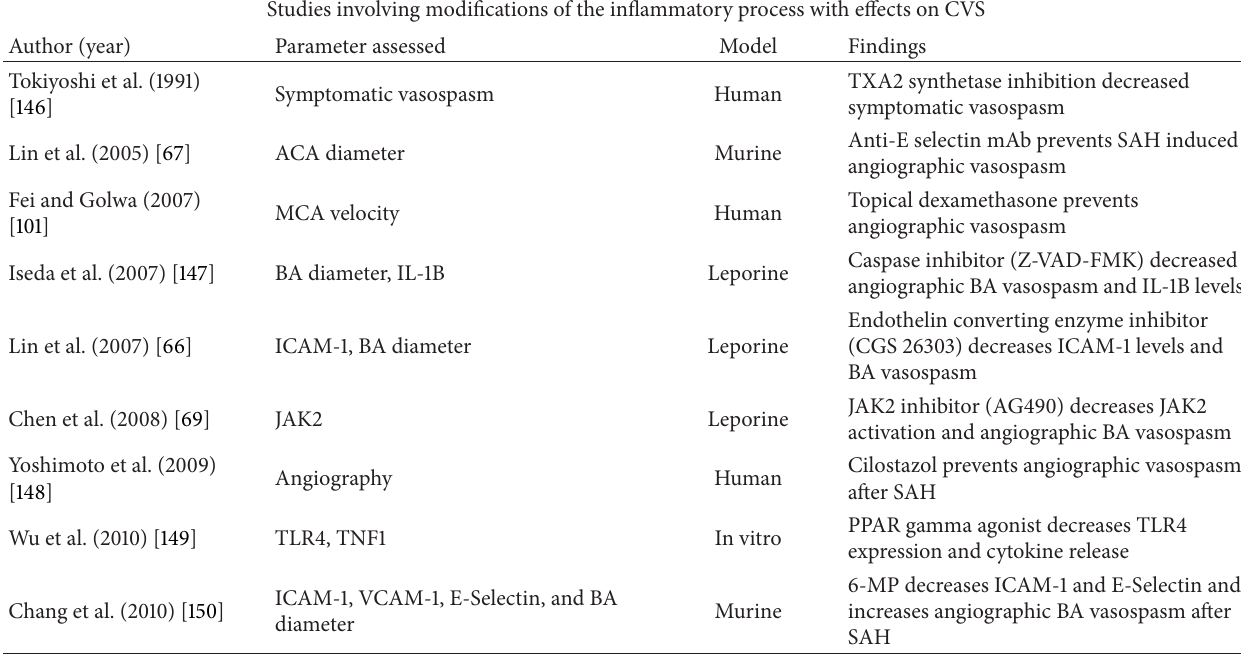
Table 2: Early studies report improvement in experimental proxies of CVS in various models. Studies involving modifications of the inflammatory process with effects on CVS